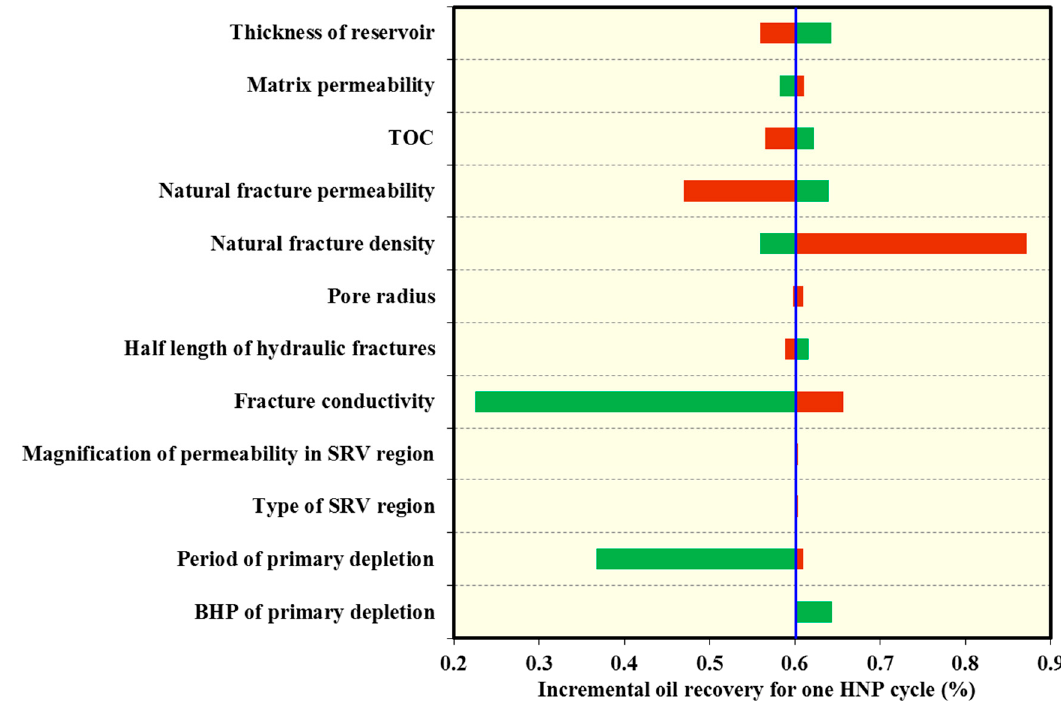
Figure 31. Tornado chart indicating the most and least sensitive parameters for incremental oil recovery. Each green bar corresponds to a sensitivity measure (compared to a base case) when a parameter is set to its lower bound. The red bars are for the upper bounds. The vertical blue line denotes the base case.